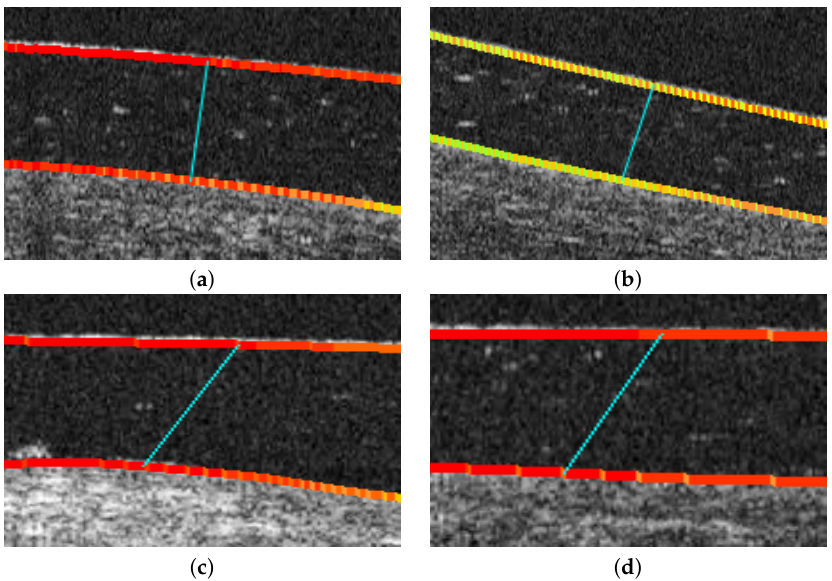
Figure 11. The main limitation of the normal direction paradigm for the calculation of the distance between the cornea and the SCL. ( a , b ) Correction of the normal direction paradigm to the problem of the vertical line metric examples of Figure 10c,d. ( c , d ) Examples of the limitation of the normal direction paradigm to sudden changes in the contour of the regions, where the normal distance does not accurately measure the cornea–CL